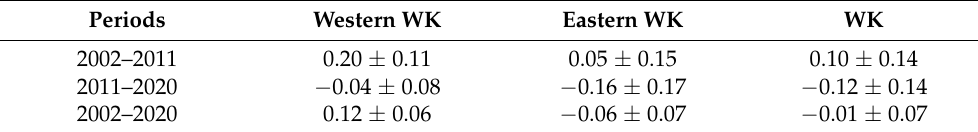
Table 2. Spatial variations of SMB in WK over three different time spans. (unit: m w.e. a − 1 ). Periods